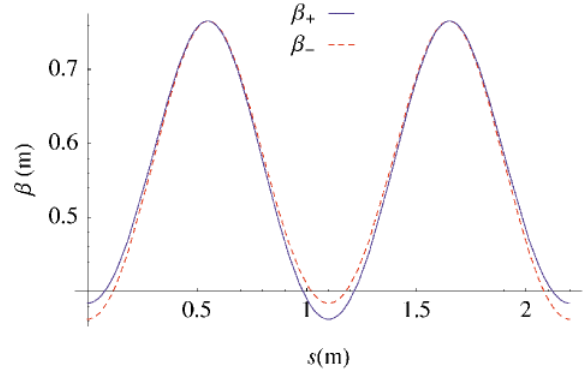
FIG. 1. (Color) Model for the energy loss d E (cid:1) ds and acceler- ating electric field E (cid:2) s (cid:3) sin f s over one section.